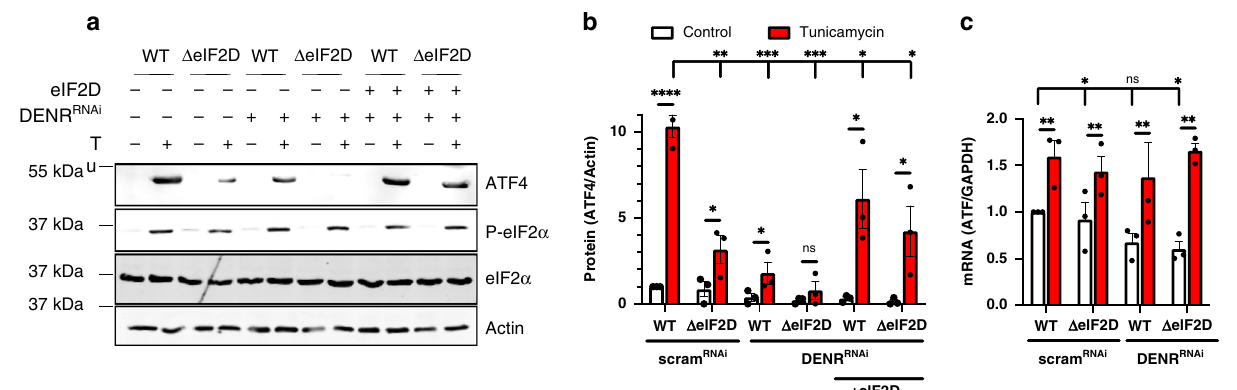
Fig. 7 Regulation of ATF4 by eIF2D and DENR is conserved in human cells. a Western blots of total cell lysates from control human HAP1 cells (WT) or equivalent cells with CRISPR-Cas9 mediated deletion of the eIF2D locus ( Δ eIF2D). Cells were transfected with scrambled RNAi or DENR RNAi, and treated with DMSO or Tunicamycin (Tu, 10 μ g/ml). pcDNA-heIF2D was used to re-introduce human eIF2D into cells. The blots were probed with antibodies recognizing ATF4 (panel 1), phospho-eIF2 α (panel 2), total eIF2 α (panel 3), and actin (panel 4). b Quantitation of ATF4 protein levels in a as normalized to the loading control (actin). Data are the mean of 3 independent experiments. c qPCR analysis of ATF4 mRNA in HAP1 cells from a normalized to GAPDH. Data are the mean of three independent experiments. Error bars represent standard error, p values were calculated using the two-tailed t -test with * p < 0.01, ** p < 0.001, **** p < 0.00001 and n.s. not signi fi cant. Please see Source Data Files for raw data in a – c